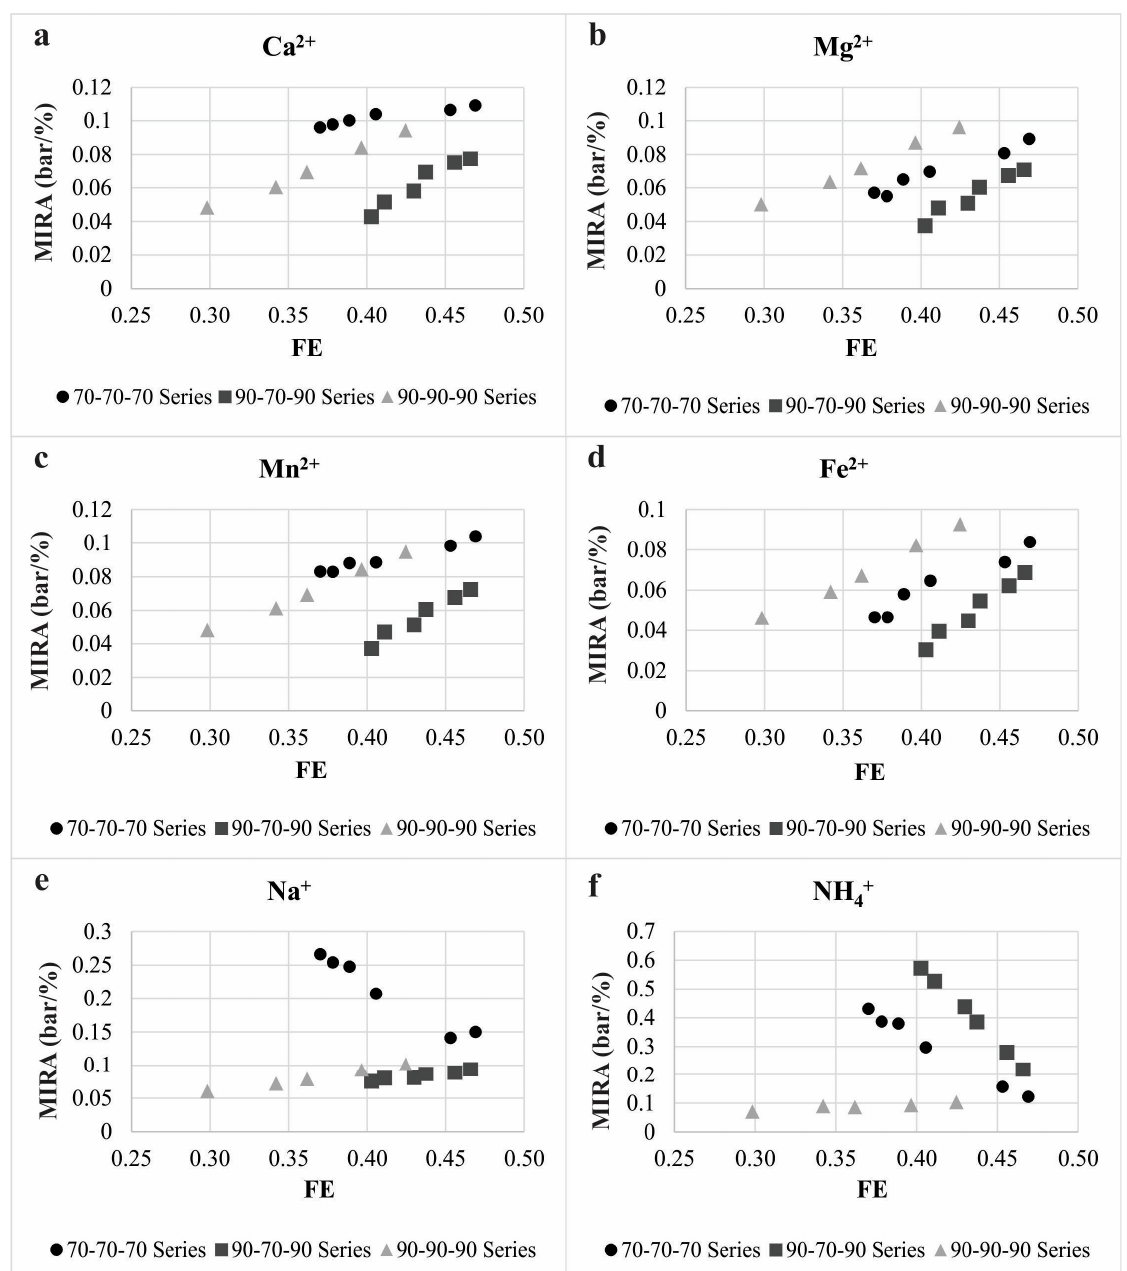
Figure 5. Mutual relation of nanofiltration pressure-driven indicator and ionic molar concentration of calcium ( a ), magnesium ( b ), manganese ( c ), iron ( d ), sodium ( e ) and ammonium ion ( f ) in the dependence of flux utilization. Table 5. Average relative permeabilities, slopes, intercepts (n), and linear regression measure of all obtained MIRA vs. FE plots.